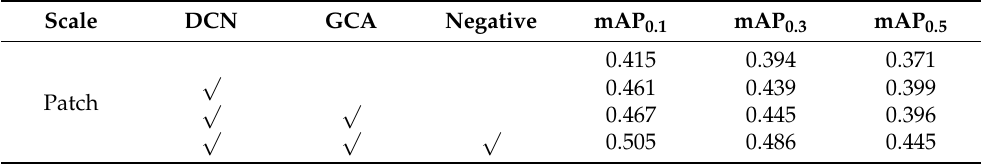
Table 7. The ablation results for the proposed DGCA-RCNN model at three different IOU thresholds. The contributions associated with DCN, GCA and tagging of negative samples were